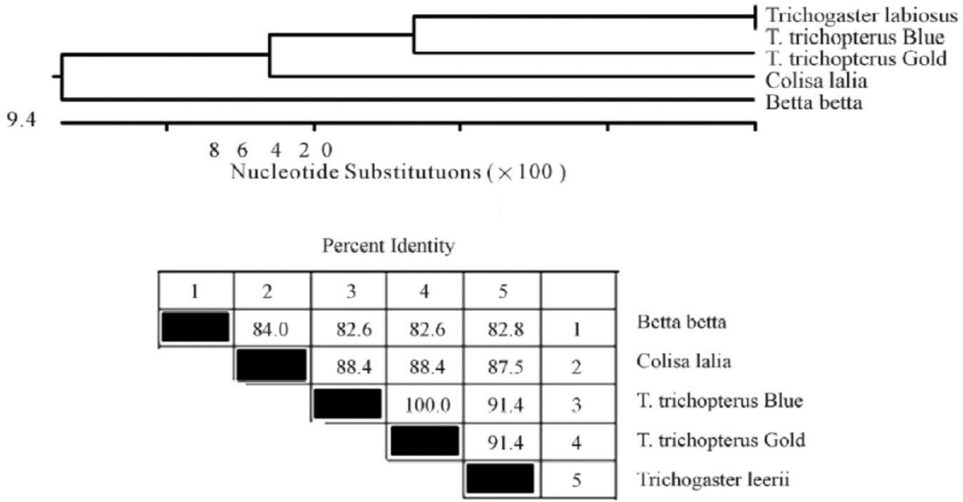
Figure 7. Phylogenetic tree constructed from analysis of 12S rRNA gene sequences of T . trichopterus (blue gourami and gold gourami), T. leerii (pearl gourami), C. lalia (dwarf gourami), and B.